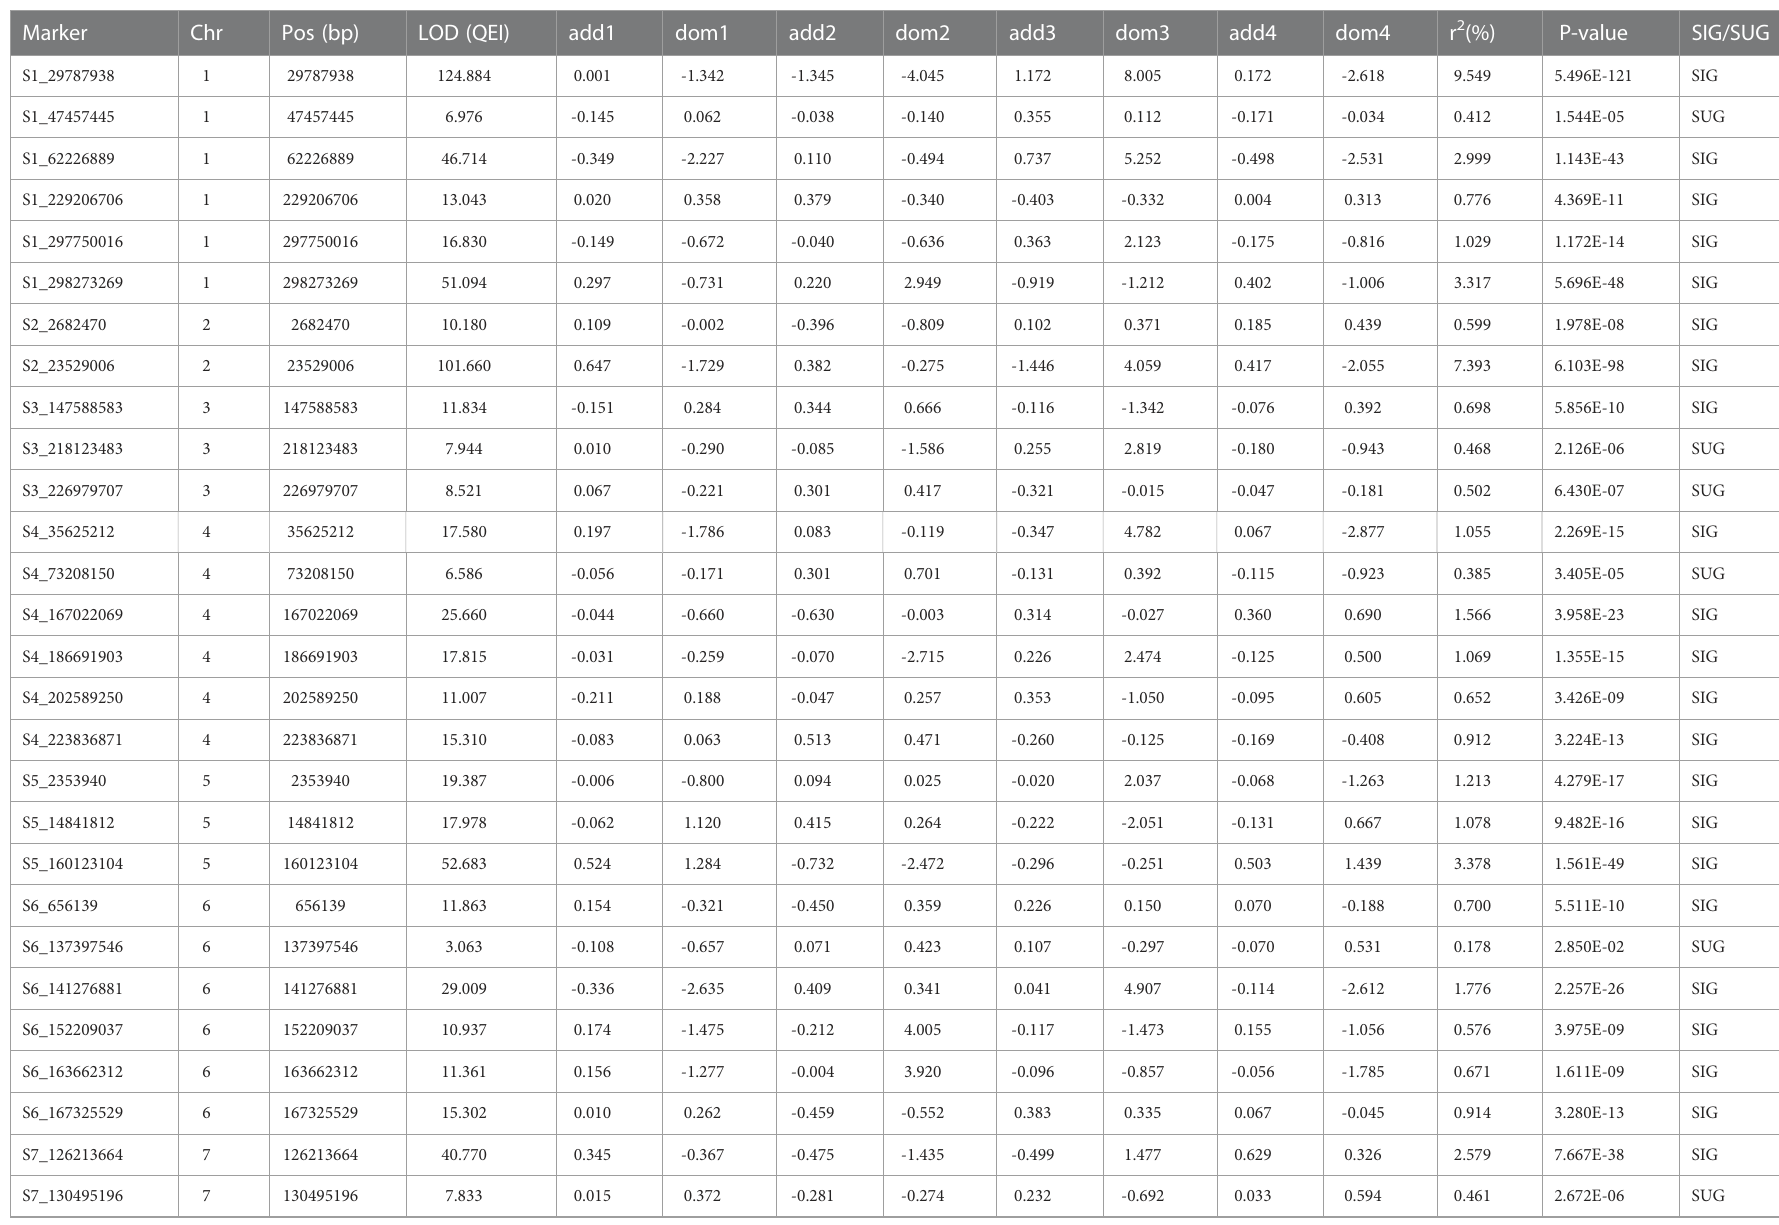
TABLE 1 Results of 37 QEIs for trait ASI using multi-environment joint analysis of 3VmrMLM.